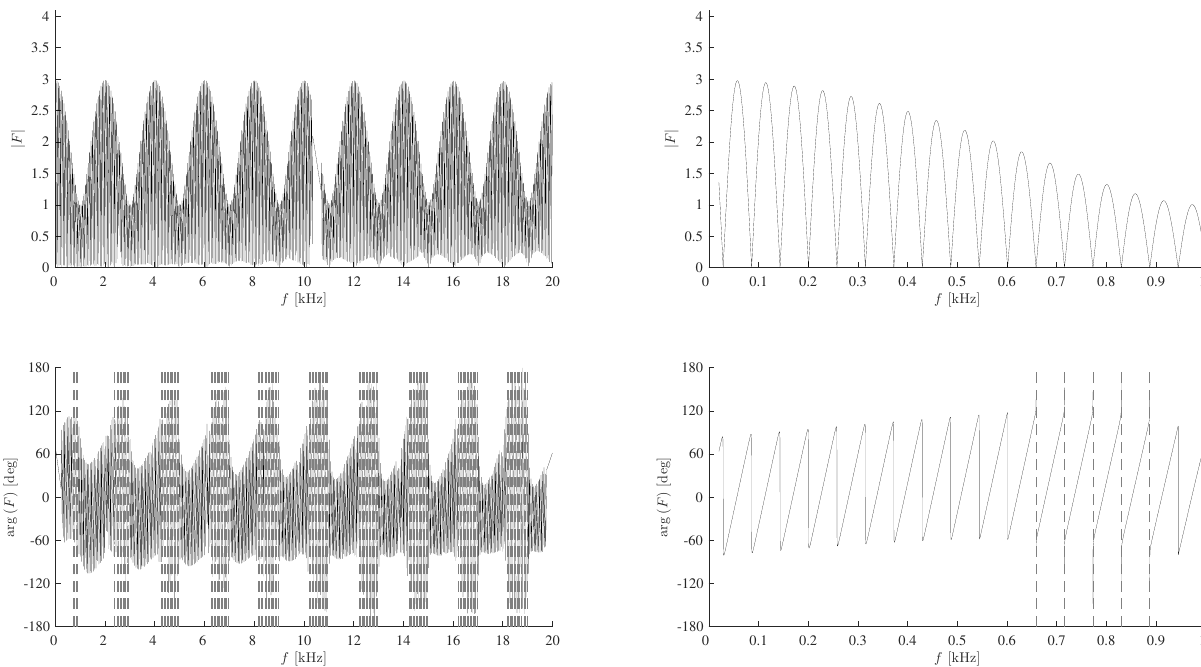
Figure 5: The same as Figure 3, but for halved reflection factor on the ground, R h = 0.5 .